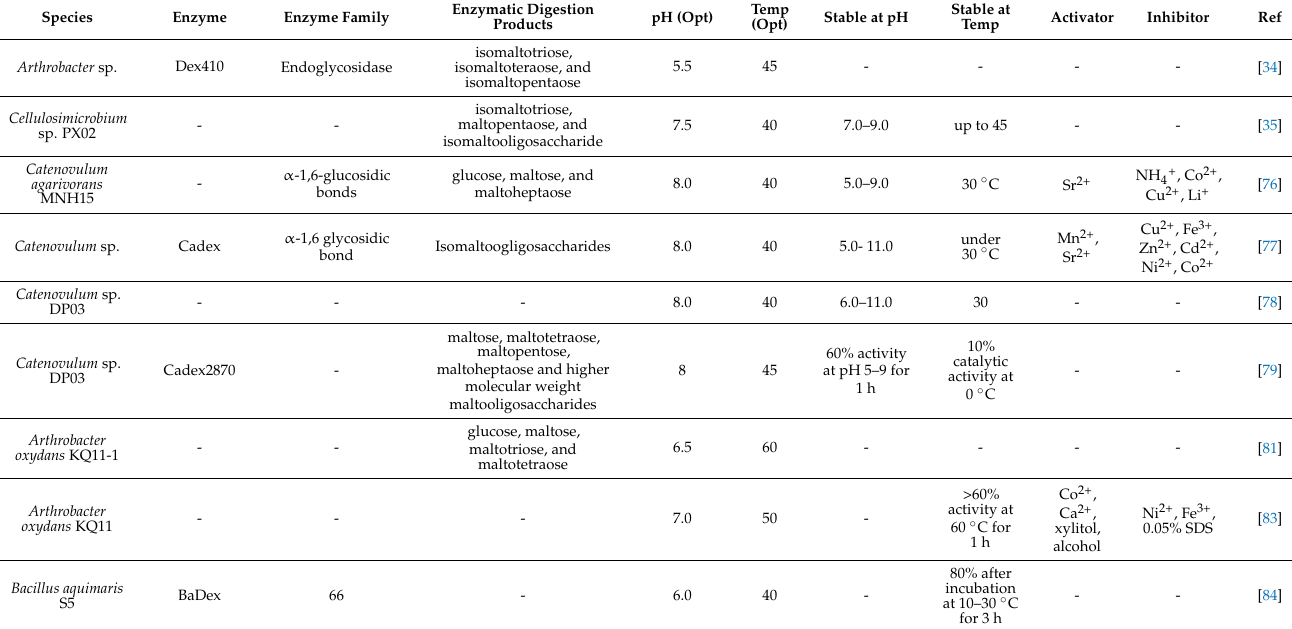
Table 2. The physicochemical properties of marine bacterial